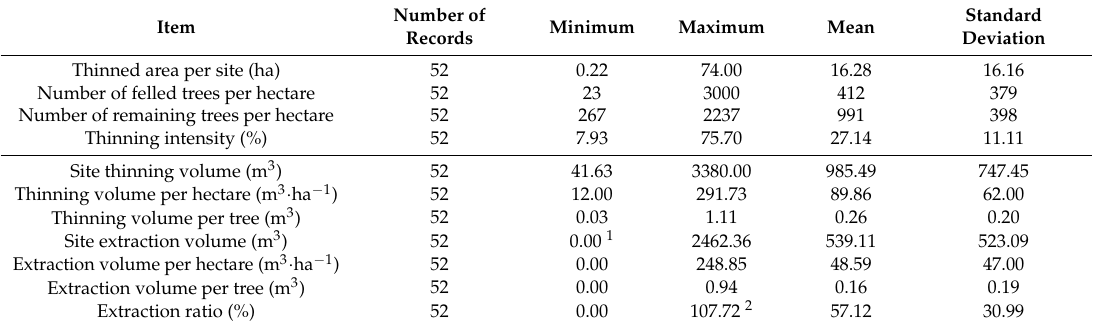
Table 4. Thinning intensity, thinning volume, extraction volume, and extraction ratio of thinning sites. Number of Minimum Item Records